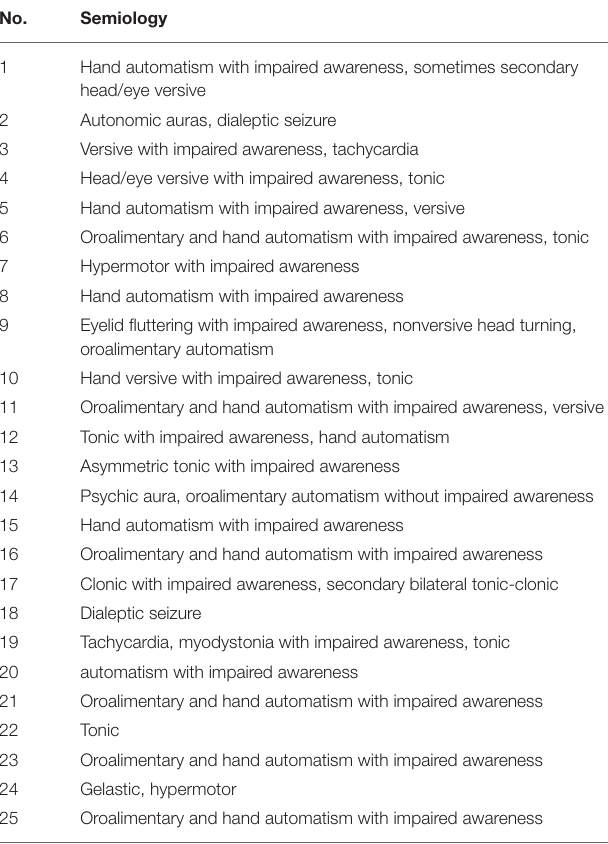
TABLE 2 | Semiology of epilepsy patients in this